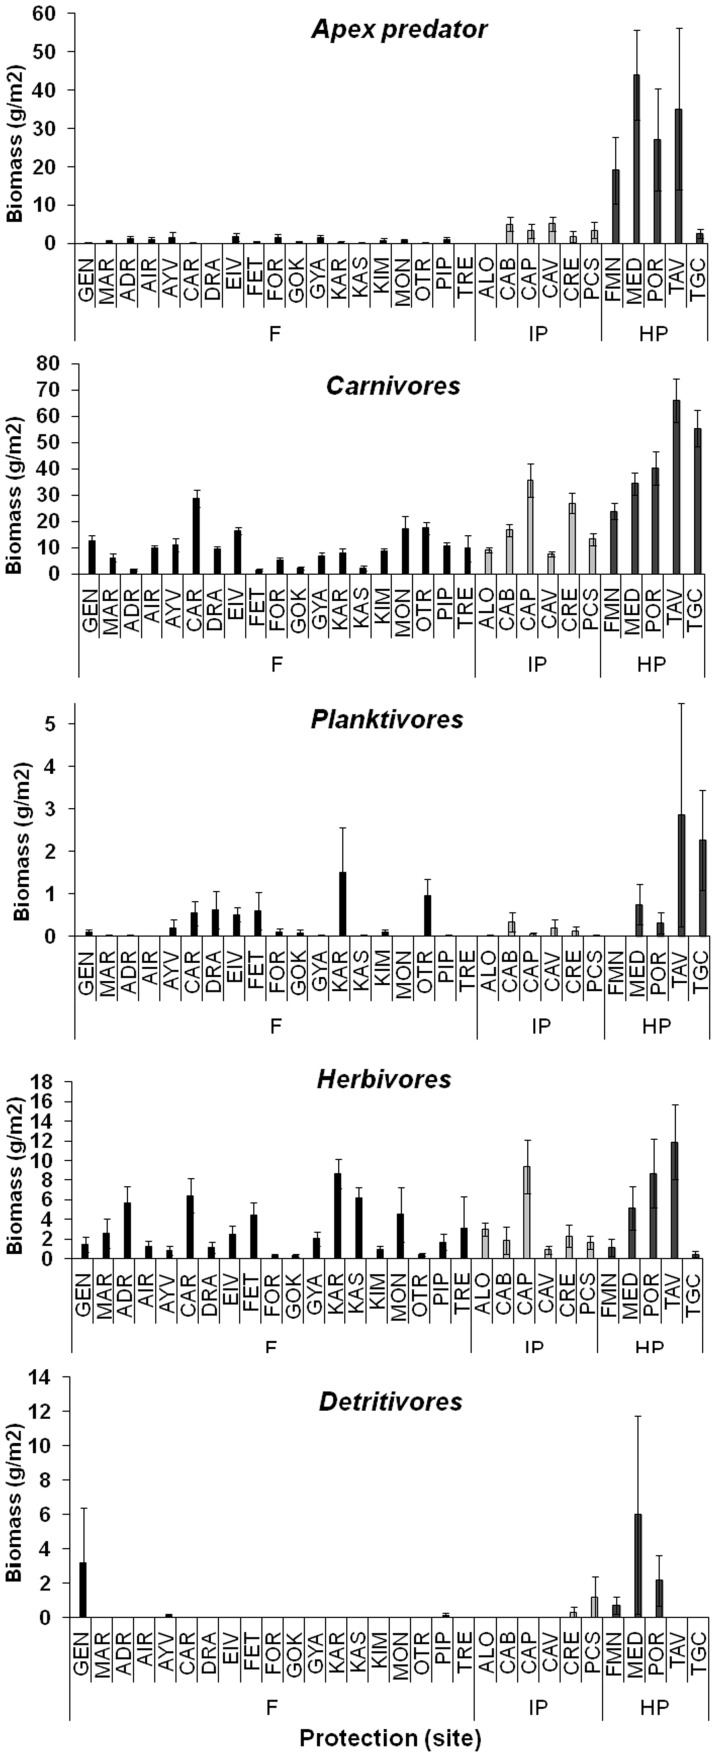
Mean values (± SE) of biomass per transect per each trophic group at each sampling site (see Figure 1 for complete site names).Black bars indicate fished areas (F), light gray bars indicate intermediate protected MPAs (IP) and dark gray bars indicate highly protected MPAs (HP).